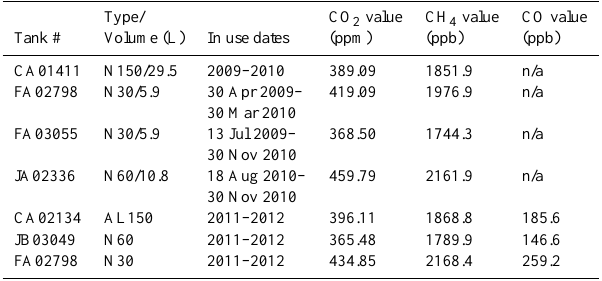
Table 2. Standard natural air reference tanks deployed for in situ calibration of the CRDS GHG analyzer, with their calibrated mole fraction values. Tanks were calibrated at NOAA/ESRL prior to de- ployment. Unless a specific date is indicated, the tank was in use for the entire